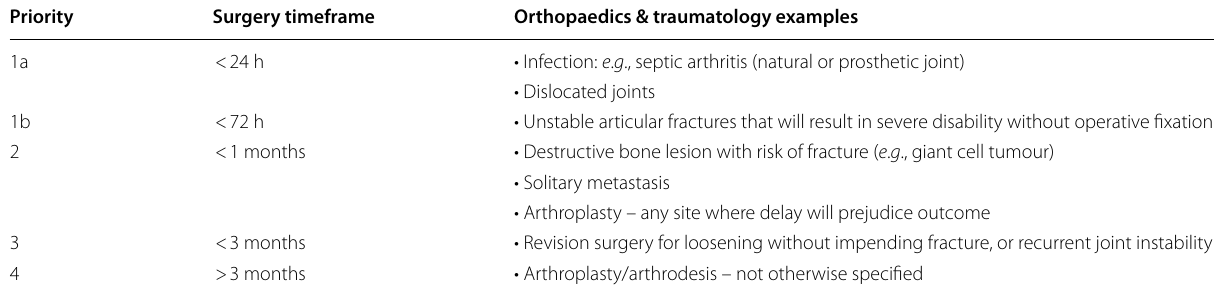
Table 4 National Health Service arthroplasty scheduling recommendations, adapted from the Federation of Specialty Surgical Associations (UK) [17] Priority Surgery